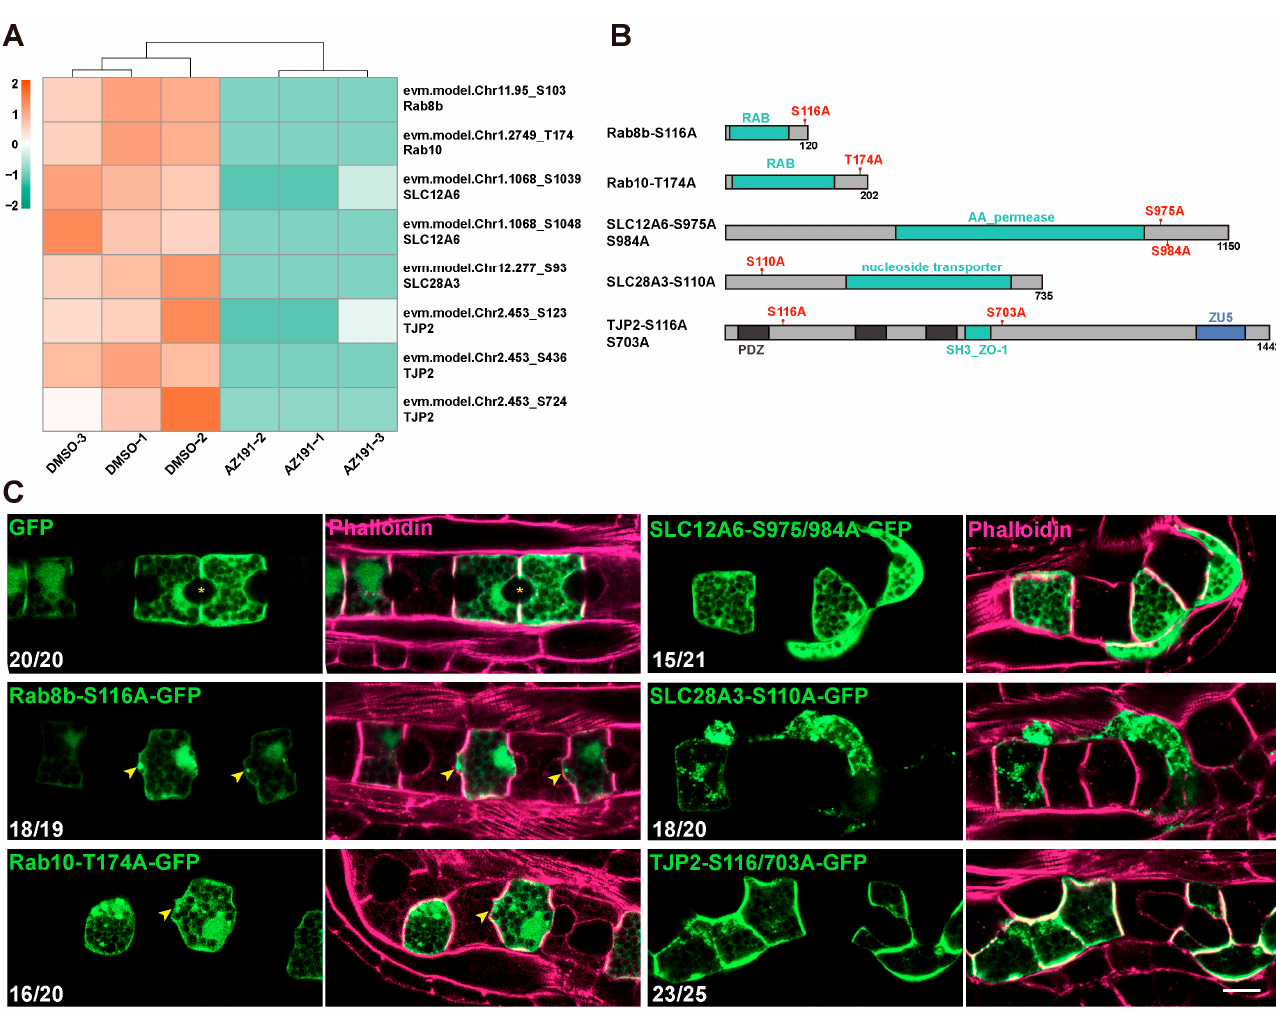
Figure 4. The analysis and in vivo phospho-de fi cient experiments of the transport-, ion transmembrane transport-, and tight junction-related proteins. ( A ) The phosphorylation level change of Rab8b, Rab10, SLC12A6, SLC28A3, and TJP2 after treatment with AZ191. Colors denote the phosphorylation levels (orange to green; high to low). ( B ) The schematic diagram of the construction of phospho-de fi cient mutants. ( C ) Confocal images showing the phenotypes of mutants of Rab8b, Rab10, SLC12A6, SLC28A3, and TJP2. The asterisk indicates lumen between two adjacent notochord cells. The arrows indicate the cell bulging. Bars: 10 µm. “n/n” represents the ratio of normal embryos/the total embryos in the GFP group or the ratio of lumen-defective embryos/the total embryos in phospho-de fi cient groups.